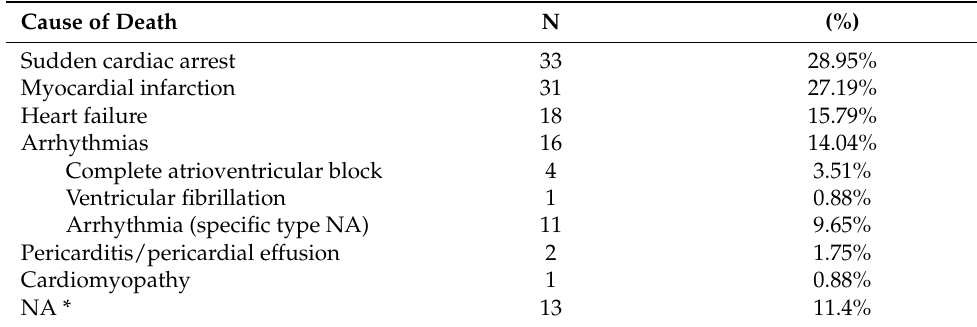
Table 2. Characteristics of the 114 FAC-related deaths.